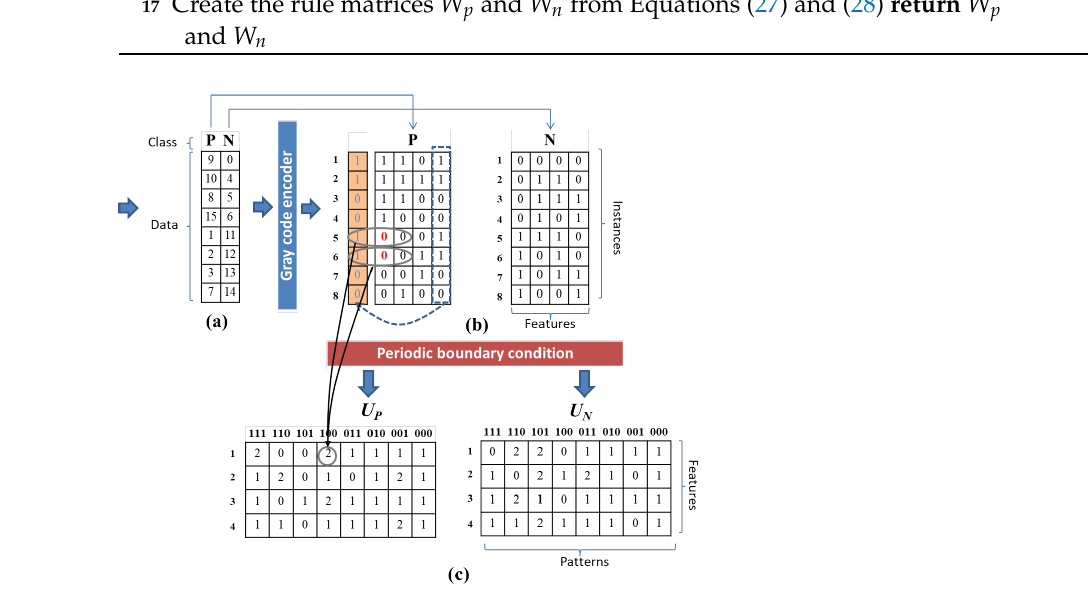
Figure 3. The initial rule matrices process consists of three steps: ( a ) converting the input data into binary data using a gray code encoder; ( b ) creating initial rule matrices with periodic boundary conditions; and ( c ) generating initial rule matrices for both positive and negative